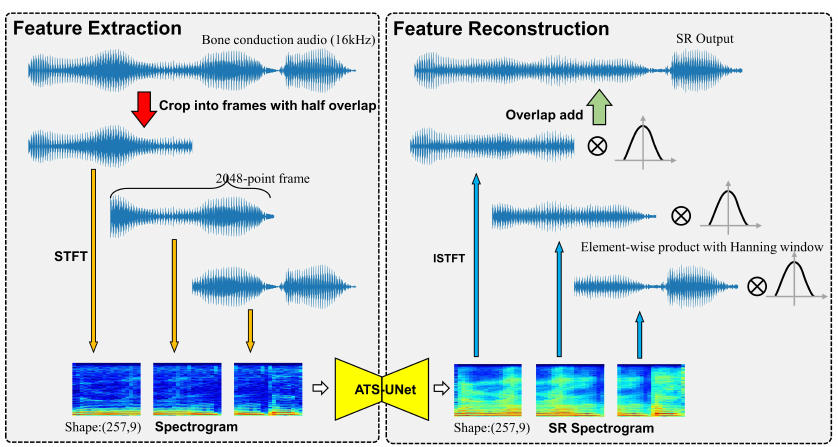
Figure 5. Feature extraction and reconstruction.